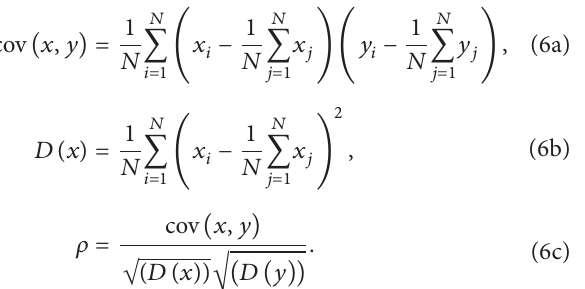
(𝑥(𝑖, 𝑗) and 𝑦(𝑖, 𝑗)) are two adjacent pixels. For highly secured image 𝜌 must be very close to